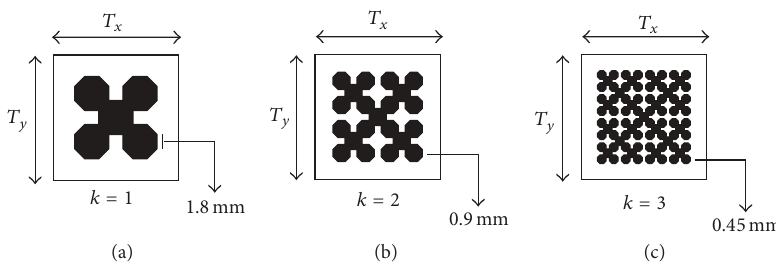
Figure 1: Illustration of Sierpinski patch elements of fractal levels: (a) 𝑘 = 1 , (b) 𝑘 = 2 , and (c) 𝑘 = 3 .